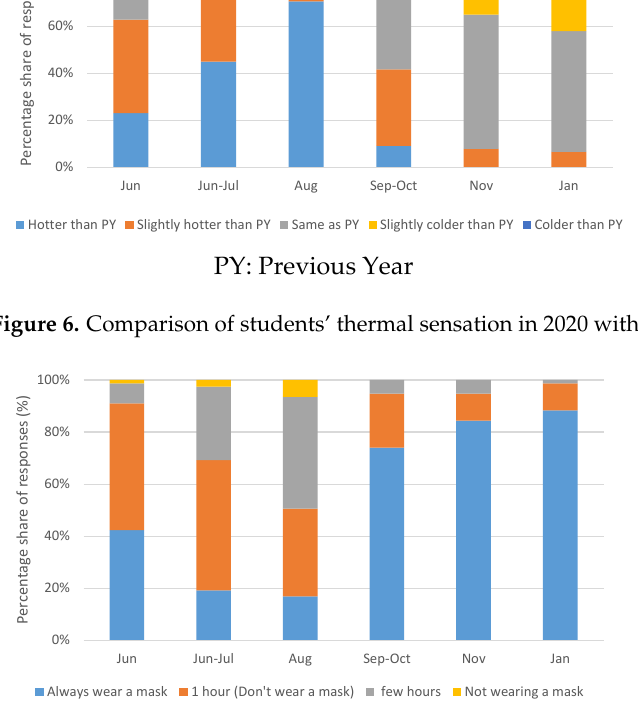
Figure 7. Wearing of masks.